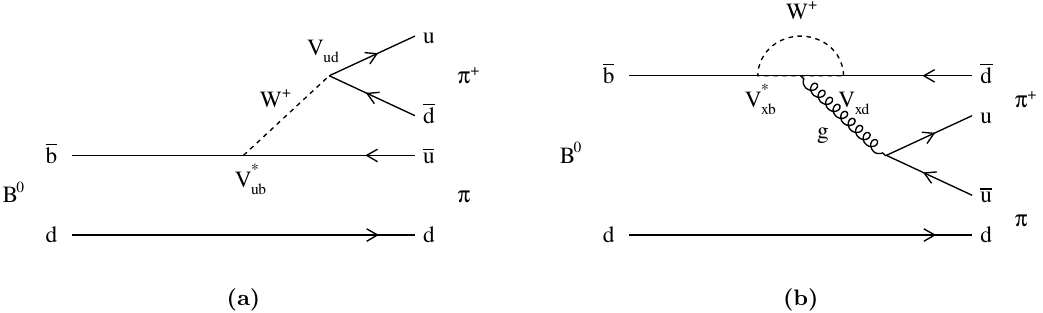
(cid:25) (cid:7) . (a) depicts the dominant 1